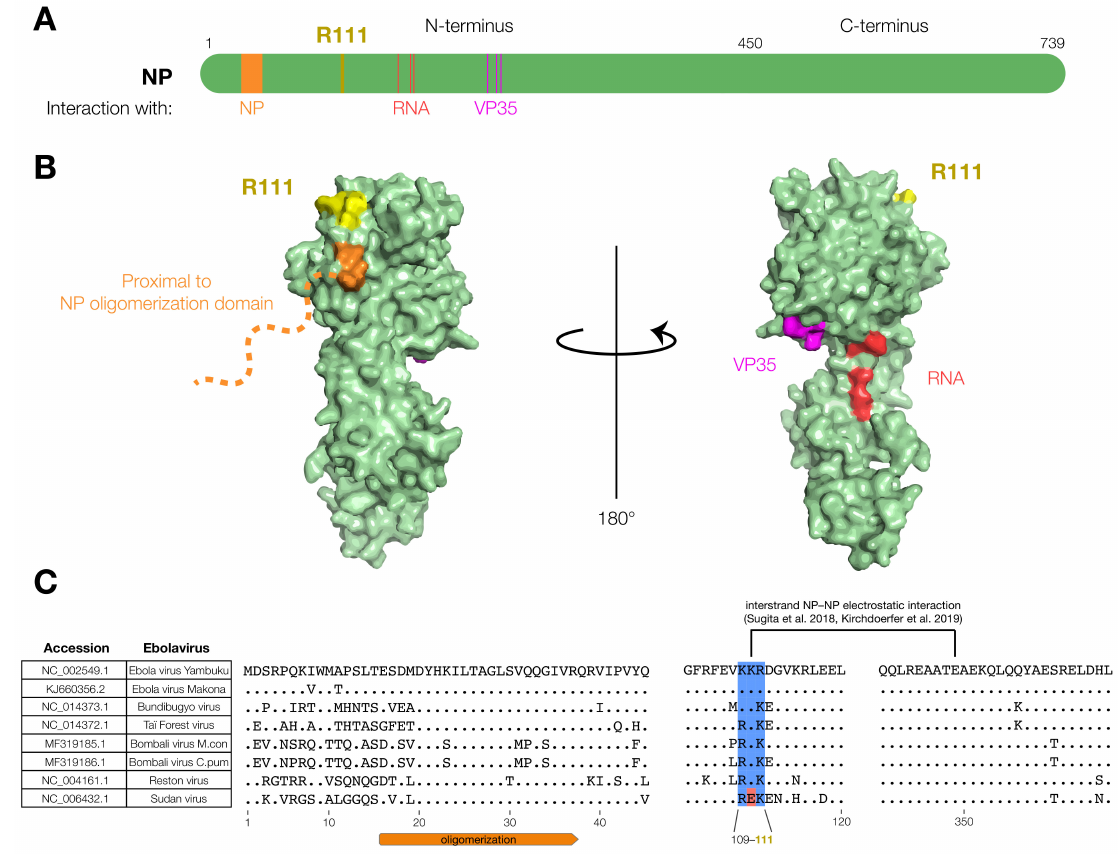
Figure 2. The EBOV NP-R111 residue is unannotated, but could impact NP–NP interaction. ( A ) Schematic of NP. R111 (yellow) lies in an un-annotated region within the N-terminal lobe. Key residues of known NP interactions are highlighted; ( B ) Crystal structure (PDB #4YPI) of NP. Though the precise location of the oligomerization domain has yet to be determined by crystallography (orange dashed line), the R111 residue (yellow) is located on the same face as residues proximal to the oligomerization domain (orange: residues 39, 40), but opposite to the VP35 (magenta: residues 160, 171, 174) and RNA (red: residues 240, 248, 252) interaction interfaces; ( C ) Alignment of ebolavirus sequences. The basic residues at 109, 110, and 111 (blue), and a recently identified electrostatic interaction between K110 and E349 [28,29], are conserved in all known ebolaviruses except Sudan virus (SUDV,